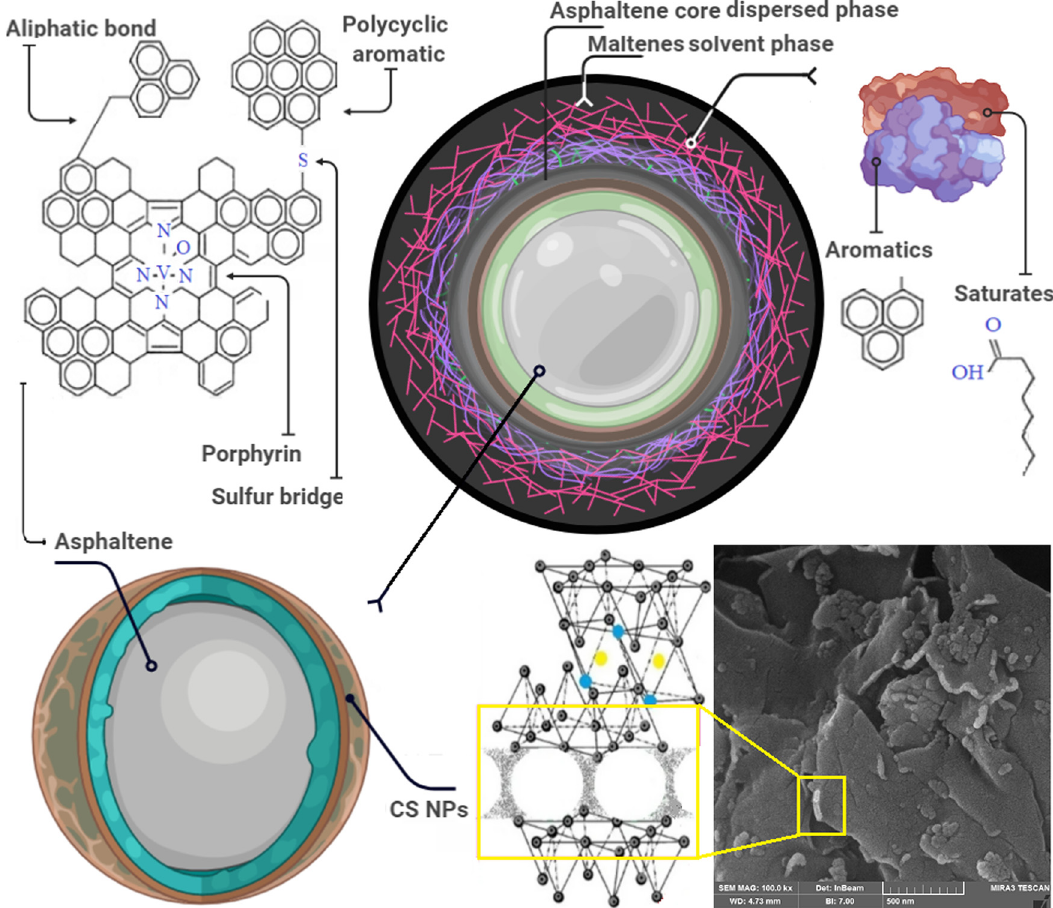
Figure 8: Schematic of action of clay/silica NPs and bitumen